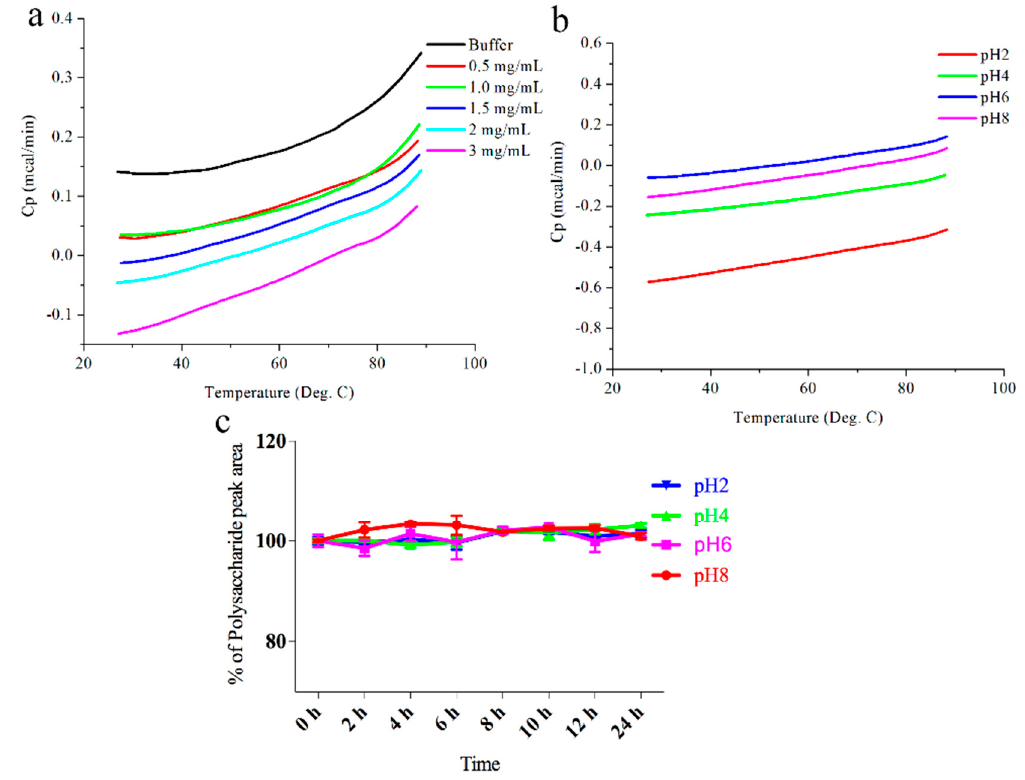
Figure 2. The stability of DOP-1-1. ( a ) DSC scans of different concentrations of DOP-1-1 dissolved in water. ( b ) DSC scans of DOP-1-1 (2 mg/mL) at pH 2, pH 4, pH 6, and pH 8 solution. ( c ) Stability of DOP-1-1 (2 mg/mL) at 60 °C. Comparison of DOP-1-1 peak percentage at different time points for pH 2, pH 4, pH 6, and pH 8 solution. All percentage values of HPLC data are normalized against the values at 0 h.